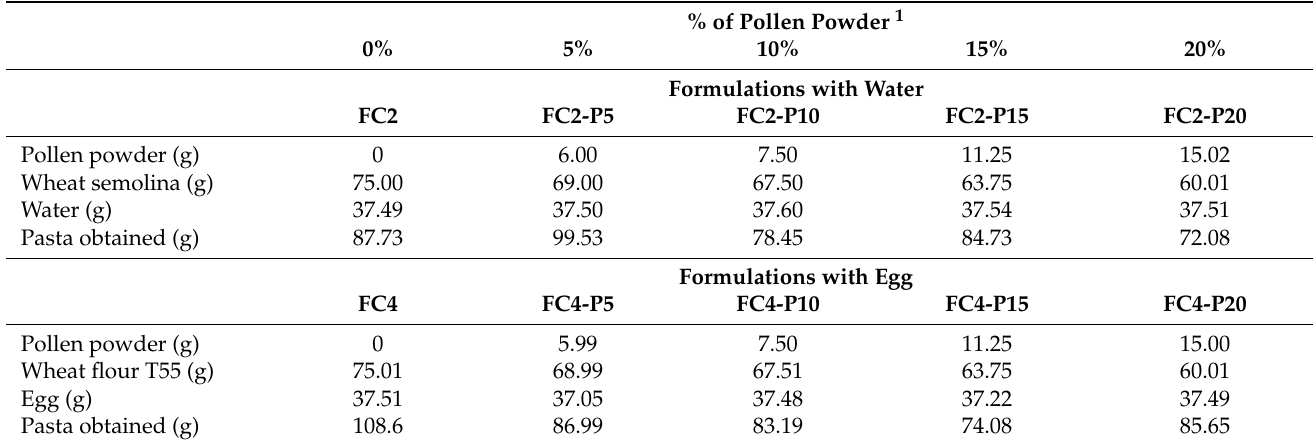
Table 3. Incorporation of pollen powder into the control formulations with water and